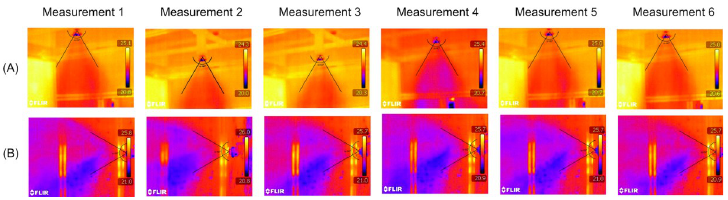
Fig 7. Measurement of the angle formed by the spray generated in the nebulizer nozzles. (A) Vertical position; (B) Horizontal position.